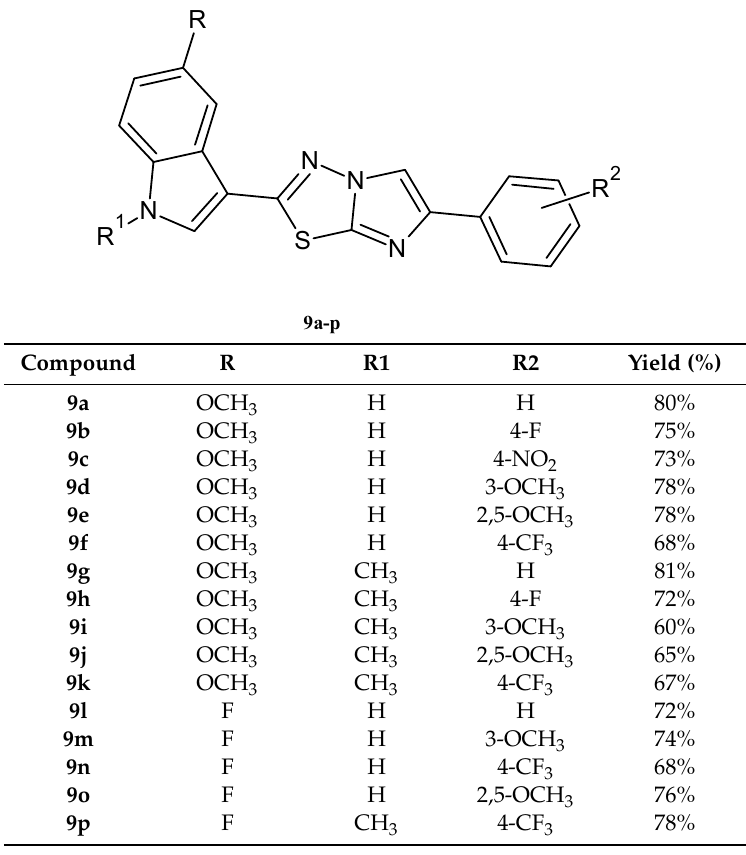
Table 1. Chemical structure of compounds 9a–p .